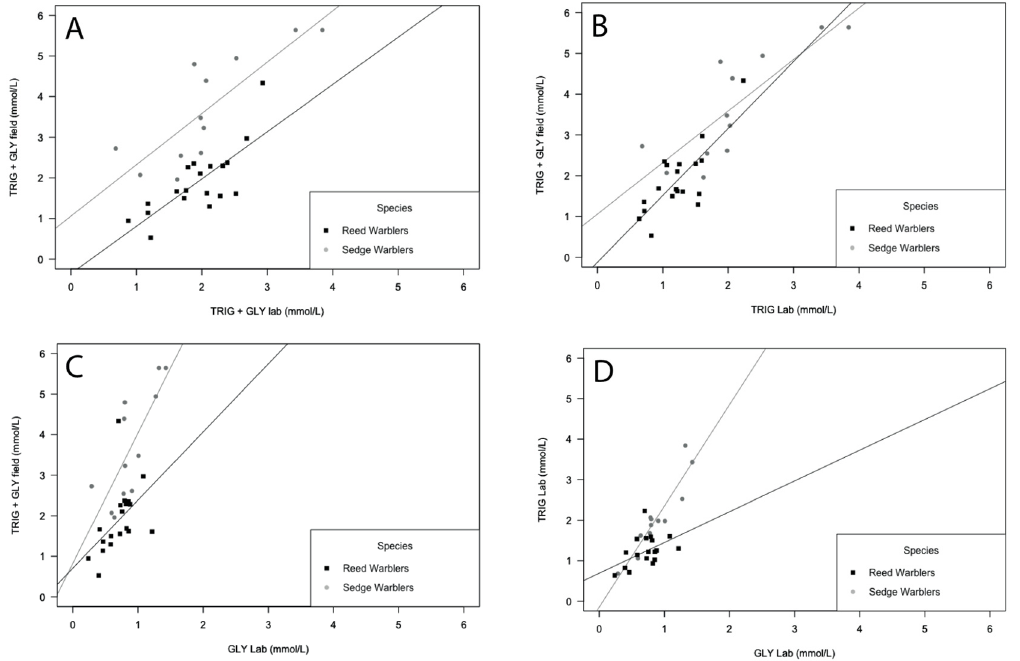
Figure 1. Spearman correlation for Sedge (grey circles) and Eurasian Reed Warblers (Reed Warblers—black squares) between: ( A ) TRIG + GLY (mmol/L) concentrations measured in the field in the laboratory; ( B ) Triglycerides (TRIG) + Glycerol (GLY) (mmol/L) concentrations measured in the field and TRIG (mmol/L) concentrations measured in the laboratory; ( C ) TRIG + GLY (mmol/L) concentrations measured in the field and GLY (mmol/L) concentrations measured in the laboratory; ( D ) TRIG (mmol/L) concentrations measured in the laboratory and GLY (mmol/L) concentrations measured in the laboratory. Field results were converted from mg/dL to mmol/L (1 mM—88.825 mg/dL of TRIG; 1 mM—88.652 mg/dL of GLY).